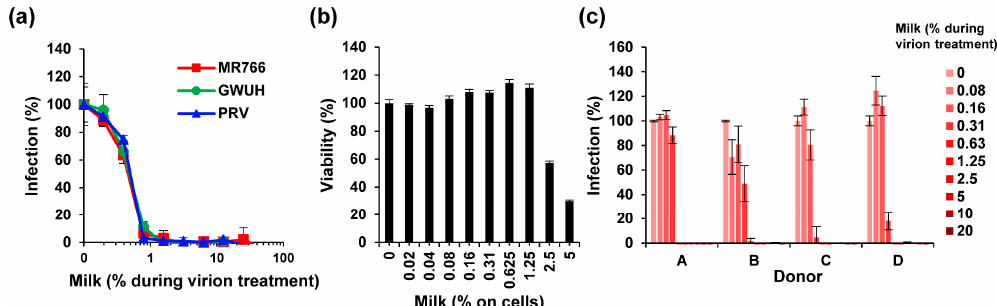
Figure 1. Effect of long-term frozen breast milk on ZIKV infection. ( a ) ZIKV MR766, GWUH or PRV (MR766: 1.58, GWUH: 2.51, PRV: 1.58 × 10 7 TCID 50 / mL) were mixed 1:1 with thawed breast milk at